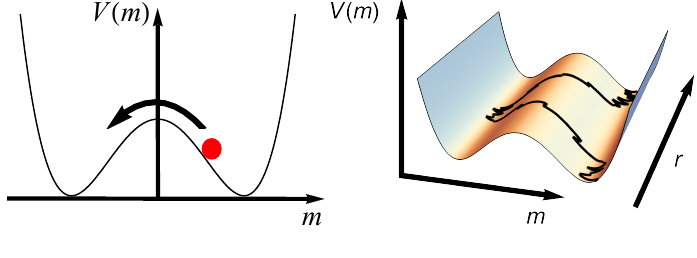
Figure 1: Left: Single particle in a 0D system whose deterministic dynamics is gov- erned by a symmetric double-well potential. In the absence of noise, the symmetry of the potential is broken by the initial conditions. However, any finite noise trig- gers consecutive transitions between the two minima of the potential and eventu- ally restores the symmetry in the long-time limit. Right: A 1D generalization of the aforementioned case for a field theory. Similarly to the 0D case there is no symmetry breaking at finite noise strength. Instead, depending on the noise strength a non-zero density of domain walls